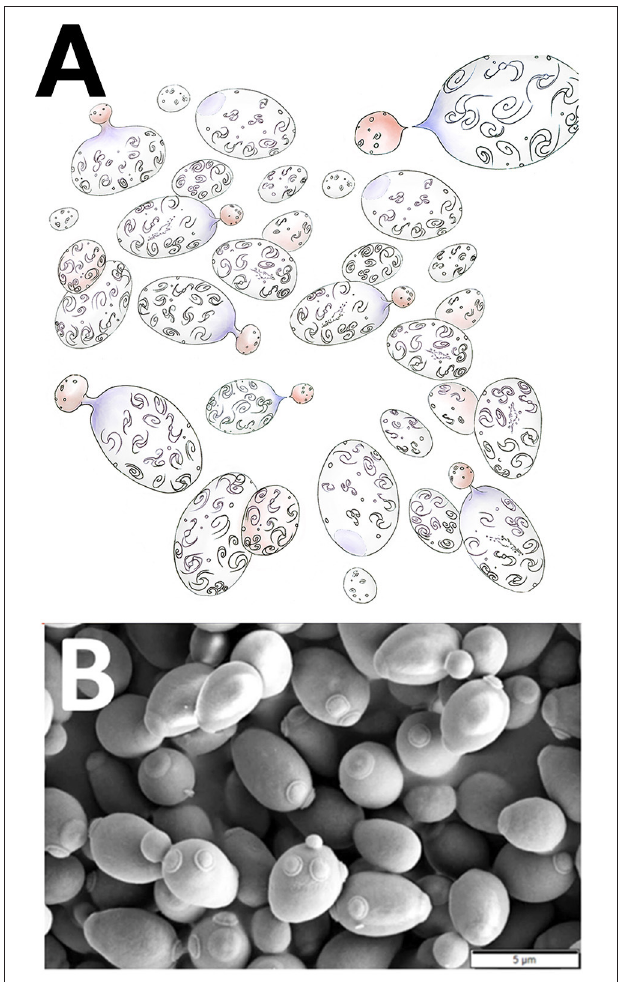
FIGURE 3 | Budding-off reproduction. (A) Artistic representation of a family of multiple universes where each parent universe buds-off offspring universes. Billions of galaxies are typically found in each universe. Note the scars left in “parent universes” by the previous budding-off of newly born universes ( Art: Sofia Matalonga Jorge ). (B) A colony of yeasts ( Saccharomyces cerevisiae ) actively budding-off for reproductive purposes. Note the scars left in mother yeast cells by the previous budding-off of newly born S. cerevisiae cells. Courtesy of Mogana Das Murtey and Patchamuthu Ramasamy (CC BY-SA 3.0, http://creativecommons.org/licenses/by-sa/3.0, via Wikimedia Commons. URL: https://commons.wikimedia.org/wiki/File